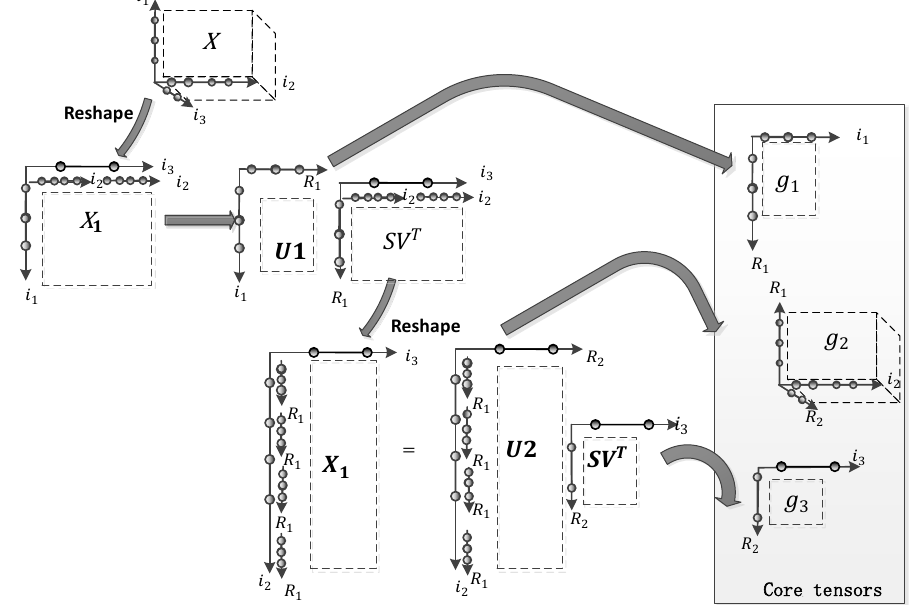
Figure 2. Computation of the TT